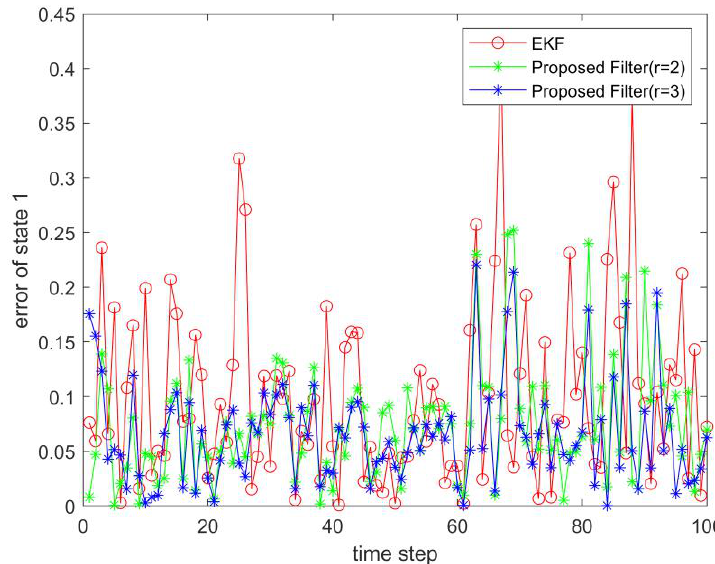
Figure 2. The actual value of state 2 and its estimation.